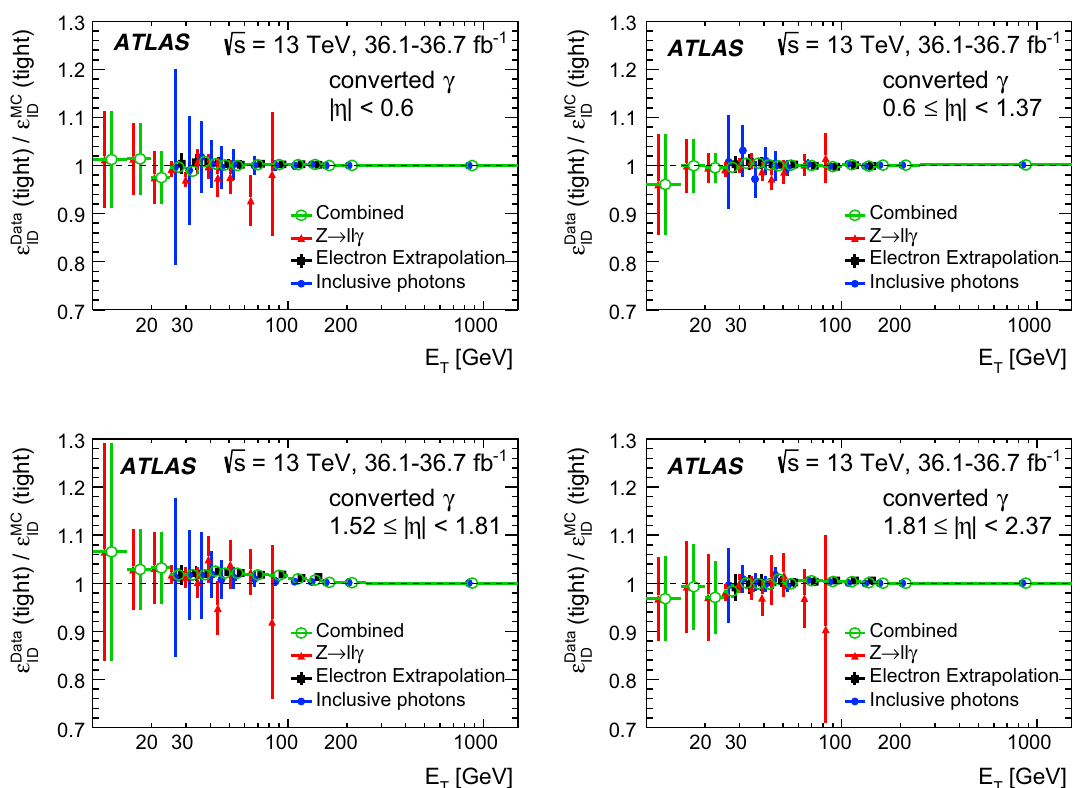
Fig. 14 Efficiency scale factors (SF) for each method and their combination for converted photons. The last bin extends to 1.5